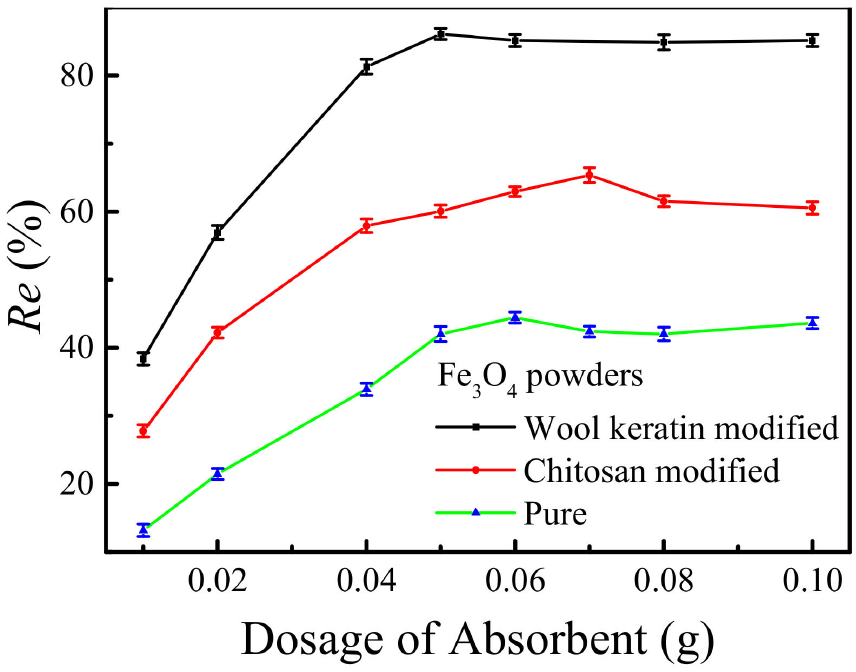
Figure 9. The effects of the dosages of as-fabricated Fe 3 O 4 powders on the removal efficiencies of Cu 2+